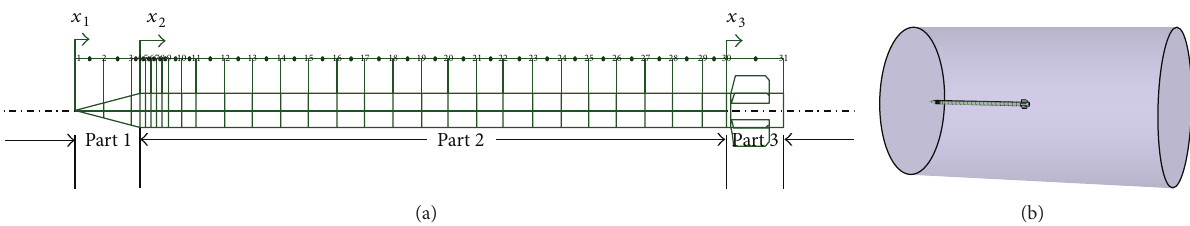
Figure 2: Model geometry and flow control volume: (a) longitudinal division of the slender rocket and (b) flow control volume.